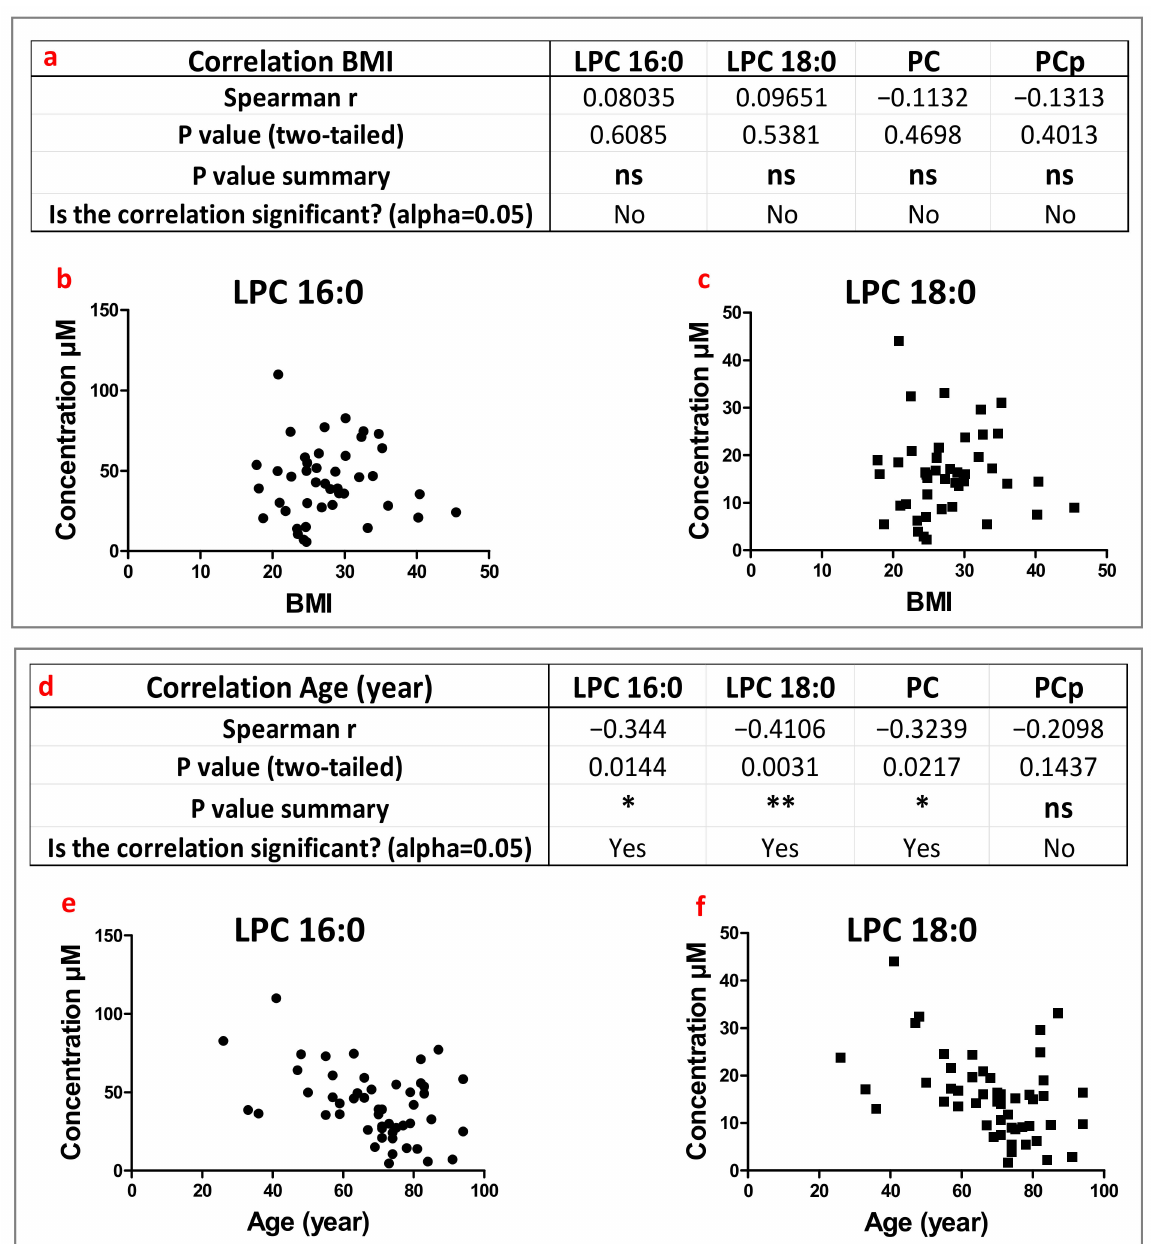
Figure 3. Correlation of lipid levels in HSF with the body mass index (BMI) and age of patients. ( a ), Table of Spearman correlation between lipid levels in HSF and BMI. ( b , c ) Correlation plots of BMI with LPC16:0 and LPC18:0, respectively. ( d ) Table of Spearman correlation between lipid levels in HSF and the age of patients regardless of joint pathologies. ( e , f ) Correlation plots of age with LPC16:0 and LPC18:0, respectively. ns: not significant p > 0.05, *: 0.01 < p < 0.05, and **: 0.001 < p <